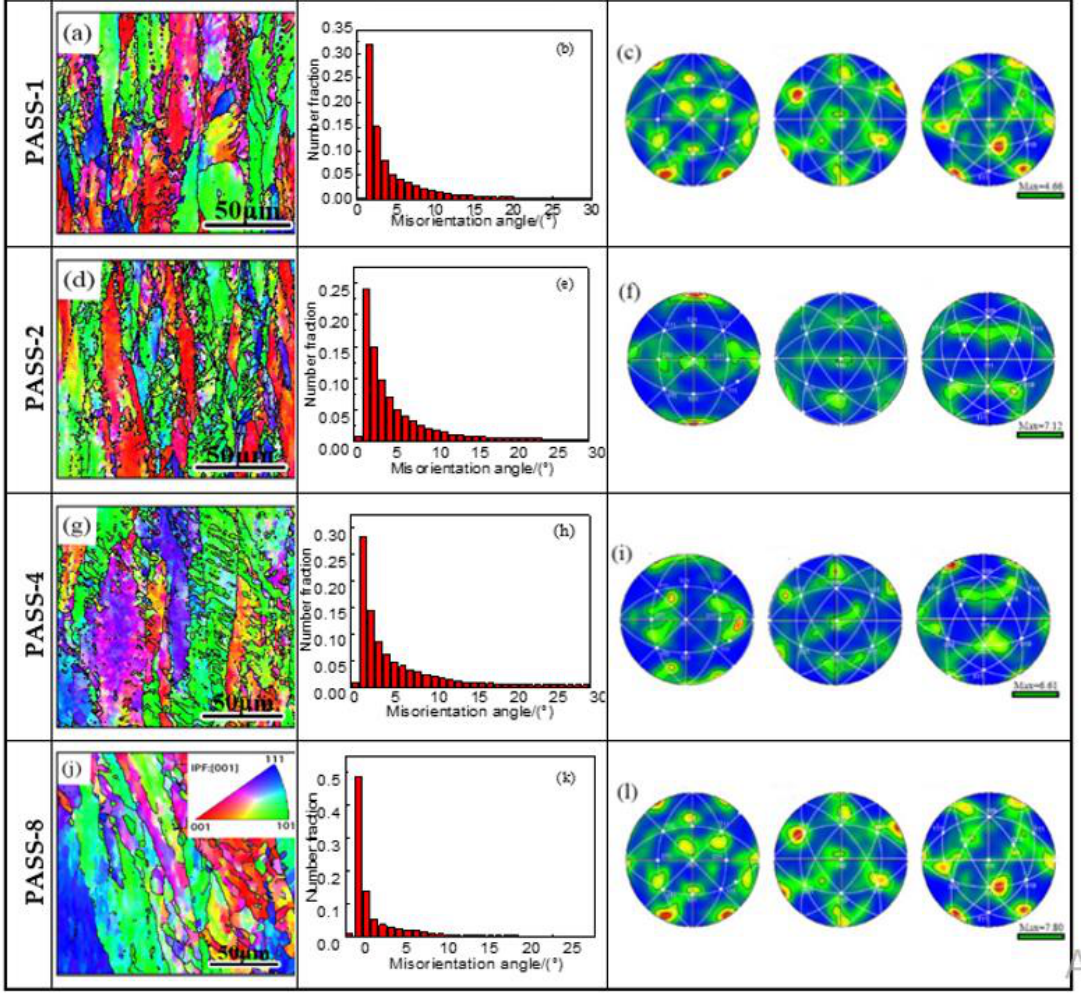
Figure 1. Electron back-scattered diffraction (EBSD), grain boundary evolution, and pole diagrams of Cu1.5Cr0.1Si alloy after C-path of ECAP deformation and aging at 350 ◦ C for 4 h.Electron back-scattered di ff raction (EBSD) after ( a ) 1 pass ( d ) 2 passes ( g ) 4 passes ( j ) 8 passes; grain boundary evolution